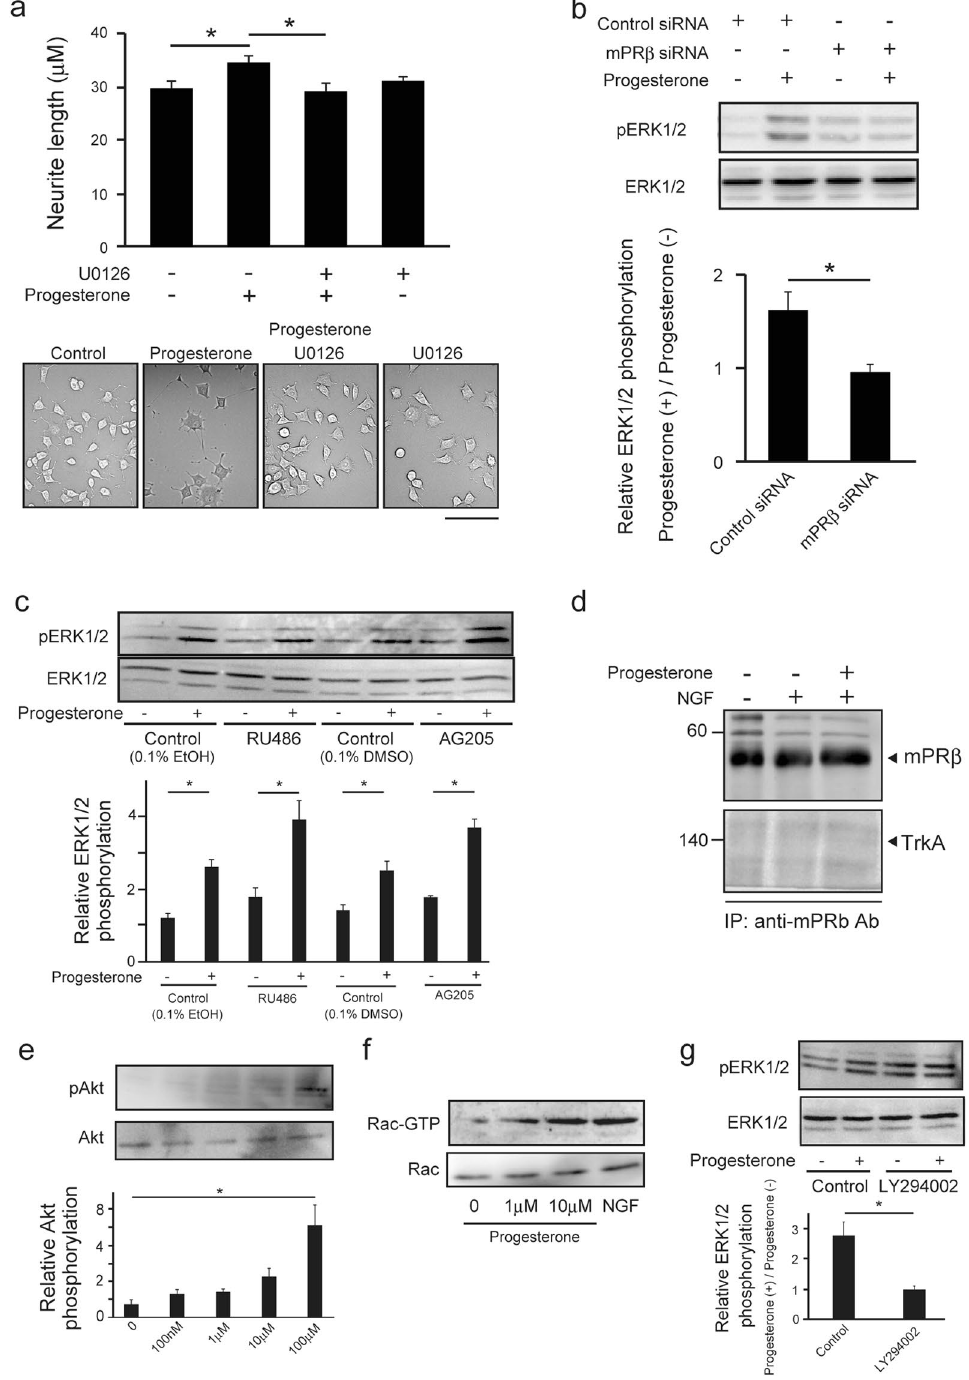
Figure 5. Inhibition of progesterone-mPR β -MAPK signaling in PC12 cells suppresses neurite outgrowth. ( a ) Inhibitory effects of MEK inhibitor (U0126) on progesterone-induced neurite outgrowth in NGF-induced neuronal PC12 cells. After 24 h in culture, cells were further cultured in DMEM containing NGF (50 ng/mL), 1% FBS, with or without U0126 (10 μ M) and progesterone (10 μ M) for 3 days. Scale bar = 200 μ m. (n = 3–5). Statistical analysis was performed by using one-way analysis of variance followed by Tukey-Kramer’s post hoc test. ( b ) Inhibitory effects of mPR β siRNA on the phosphorylation of ERK1/2 in NGF-induced neuronal PC12 cells. After being treated with Control siRNA or mPR β siRNA, cells were cultured for 3 days in DMEM containing 1% FBS, NGF (50 ng/mL) and with or without progesterone (10 μ M). ERK1/2 and phosphorylated ERK1/2 in cells were detected by western blotting with specific antibodies. (n = 3). Statistical analysis was performed by using Student’s t-test. ( c ) Effects of progesterone (10 μ M) on the phosphorylation of ERK1/2 in the presence or absence of RU486 (10 μ M) and AG205 (10 μ M) in PC12 cells. After 24 h in culture, cells were cultured in DMEM containing NGF (50 ng/mL) and 1% FBS. Cells were further cultured for 3 h in